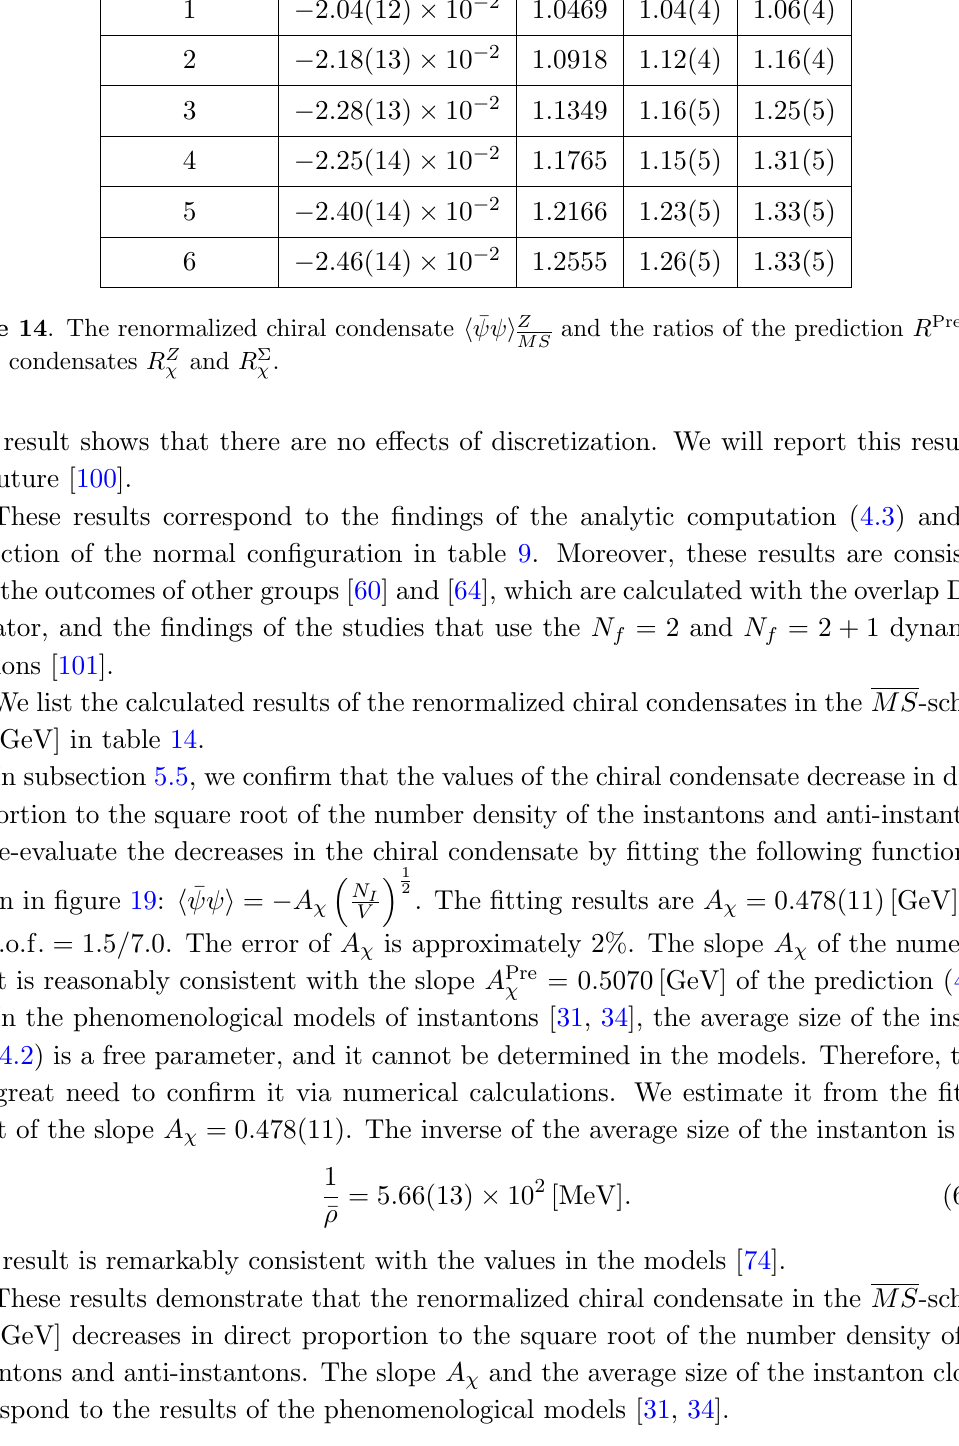
and R (cid:6) . (cid:31) (cid:31)